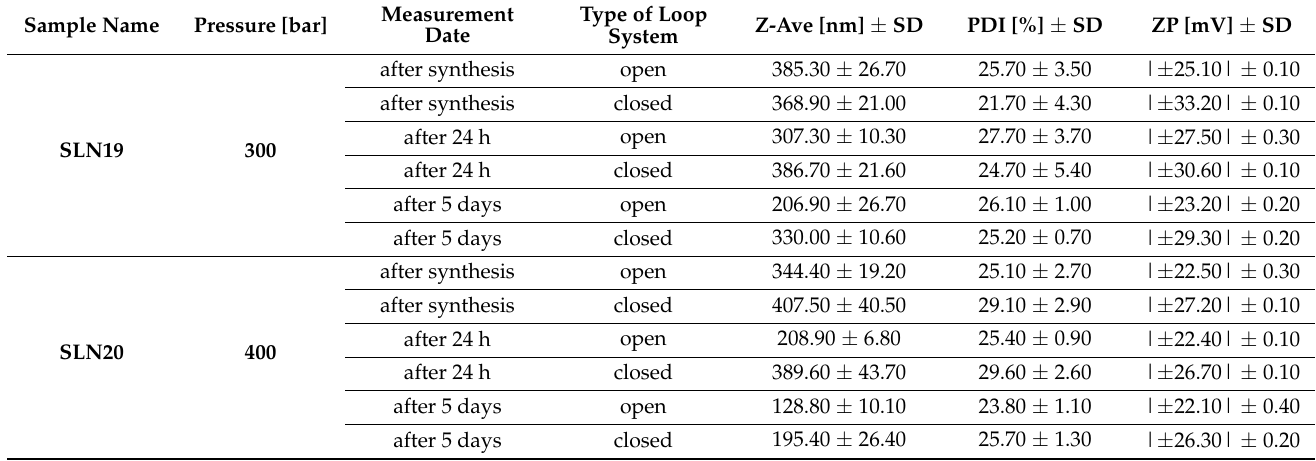
Figure 5. Comparison of the average particle size, polydispersity index (PDI) and zeta potential (ZP) of SLN-type lipid nanoparticles synthesized at 300 bar and incorporated with curcumin, measured on the day of synthesis, 24 h after synthesis and 5 days after synthesis, for a closed-loop system. The process was carried out in an open-loop and a closed-loop system in three cycles. Table 2. Summary of results for solid lipid nanoparticles incorporated with curcumin obtained, based on Softisan ® 601 lipid and Poloxamer 188 surfactant at 300 bar. The process was carried out in both an open- and closed-loop system in three